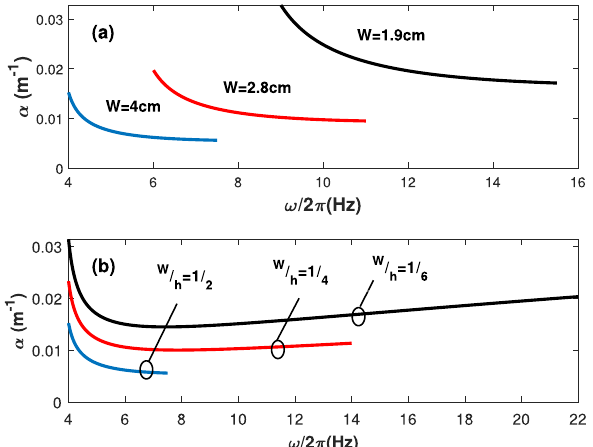
Figure 6. The attenuation factor versus the single-mode-bandwidth for TE 10 mode. ( a ) The attenuation factor versus the single-mode bandwidth for W / h = 1 / 2 . Different waveguide widths are considered. ( b ) The attenuation factor versus the single-mode bandwidth for W = 2.8cm . Different W / h ratios are